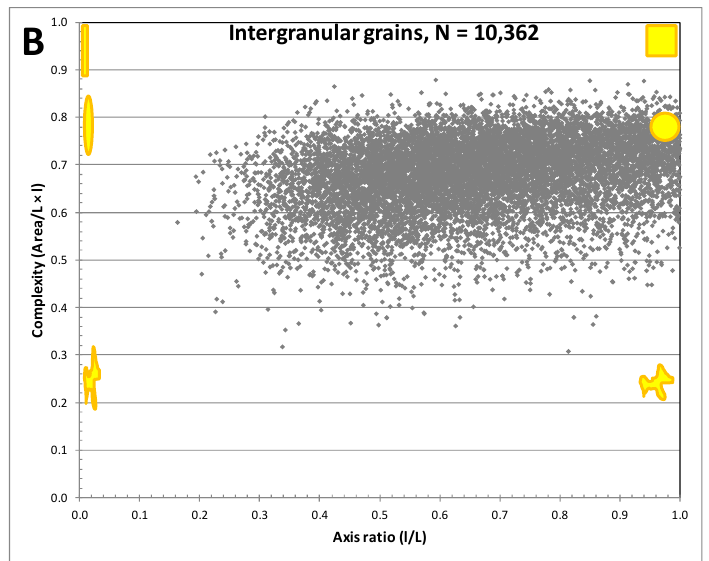
Figure 11. Relation between axis ratio and complexity for “intergranular” ( A ) and “reshaped” ( B ) grains. Other morphofacies are overlapping and intermediate between these two extremes. The axis ratio is the width divided by the length, and represents the stubbiness of the grains. The complexity is the ratio of the area, calculated from the ECD, divided by the area of the bounding rectangle (length × width). The smaller the ratio, the more contorted the shape, and an elliptical grain would have a complexity of 0.78. It is considered that the most “reshaped” grains were former “intergranular” grains that have been rounded in the course of sedimentary processes. Yellow forms are sketching the shape of grains with the corresponding axis ratio and complexity.